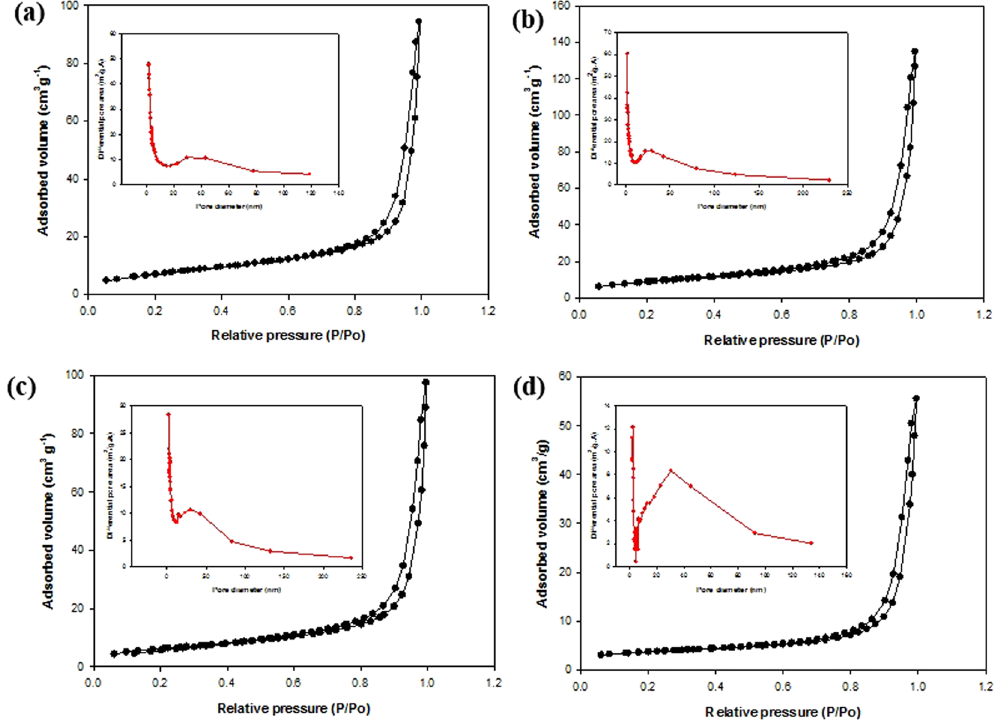
Figure 4. N 2 adsorption-desorption of ( a ) bare MoS 2 , ( b ) MPR25-1, ( c ) MPR25-2, and ( d ) MPR25-3. The insets show pore size distributions obtained using the BJH